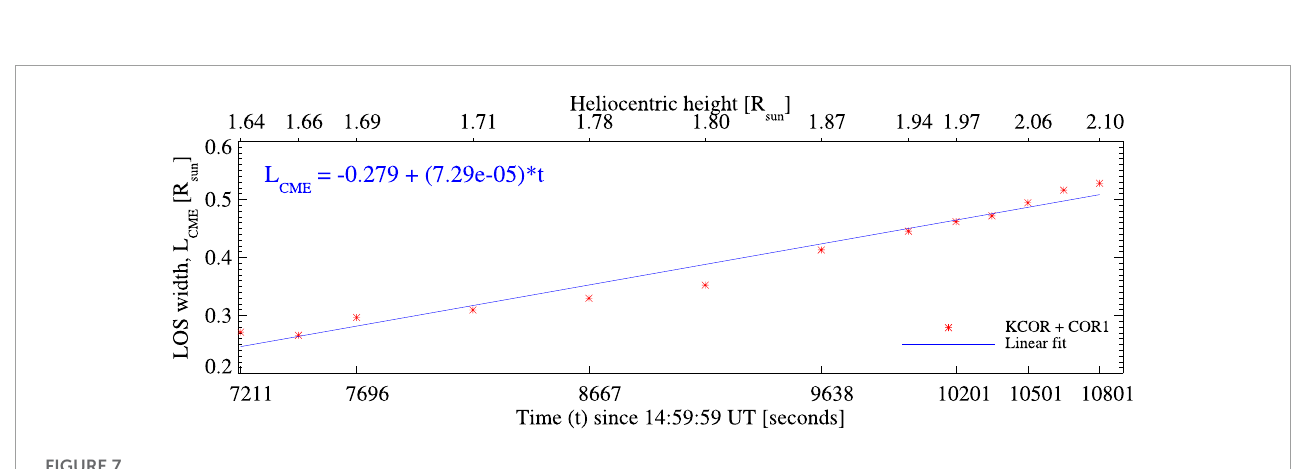
FIGURE 7 The variation of LOS width (L CME ) of the CME core with time or heliocentric height.